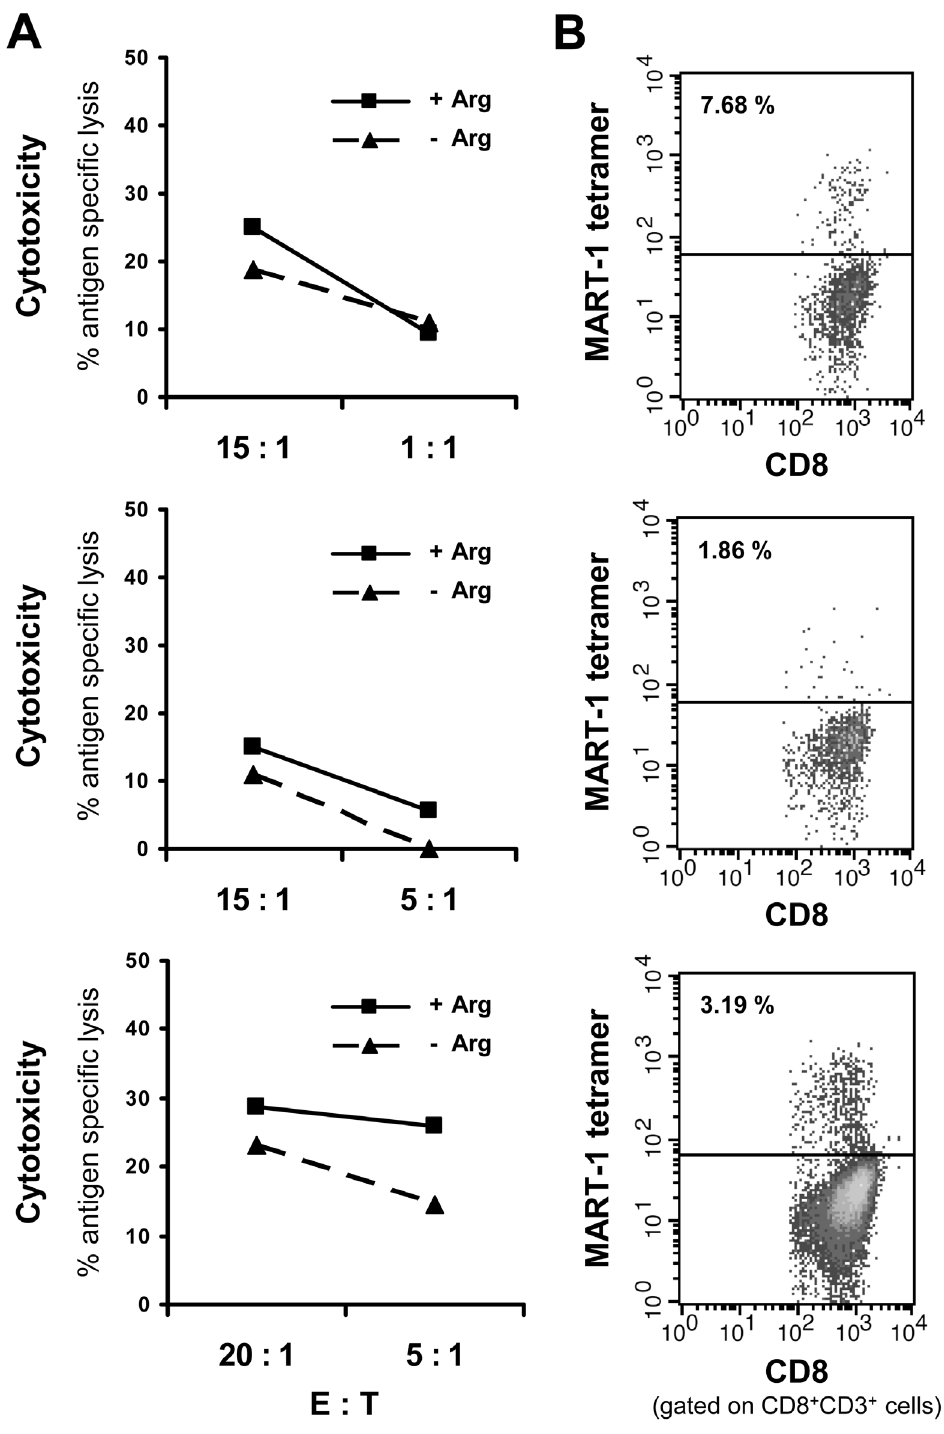
Figure 5. Arginine-independent cytotoxicity of tumor antigen specific T cells. A Expanded MART-1 aa26–35*A27L specific CD8 + T cells of 3 HD were preincubated for 24 h in the presence ( + Arg, 1000 m M) or absence ( 2 Arg) of arginine and subsequently stimulated with MART-1 aa26–35*A27L peptide or control (irrelevant) peptide pulsed T2 cells for 4 h in a [ 51 Cr]-Chromium release assay. Specific lysis of peptide loaded T2 cells upon incubation with MART-1 aa26–35*A27L specific CD8 + T cells in various E:T ratios (1:1–20:1) with/without arginine was determined in duplicates. Shown is the antigen specific lysis in % which is the specific lysis investigated with MART-1 aa26–35*A27L loaded T2 cells minus specific lysis with control peptide loaded T2 cells. B Quantitative determination of antigen specific T cells was performed by MART-1 aa26–35*A27L tetramer analysis and is displayed as % of CD8 + CD3 + T cells (analyzed before separation into the + Arg/ 2 Arg groups) together with the results for the [ 51 Cr]-Chromium release assay for each individual experiment.